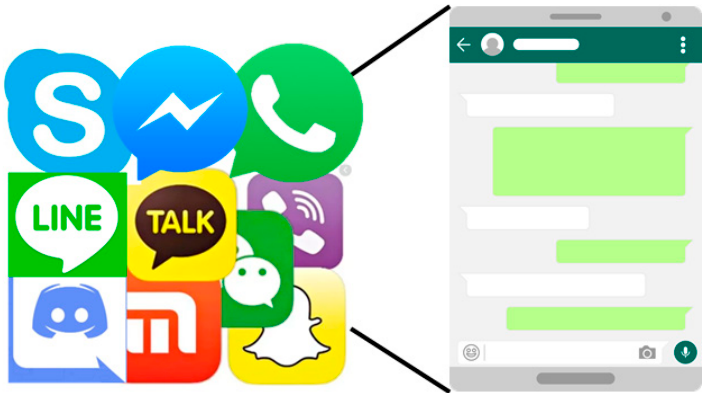
Figure 1. Typical mobile messenger application format (Skype, WhatsApp, Telegram, etc.). Table 1. Popular messenger services and their available features